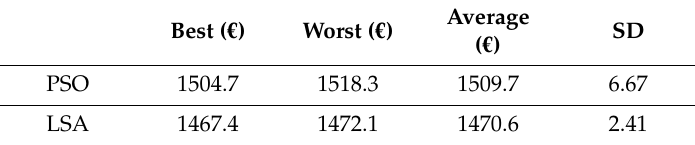
Table 2. Optimization results the first scenario (20 trials).